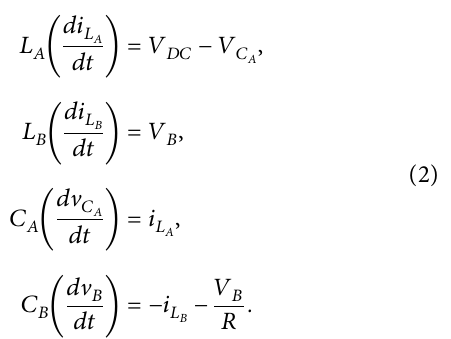
Figure 1: Te suggested inverted output buck-boost